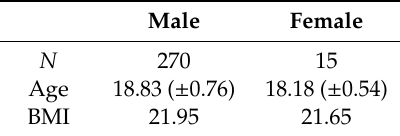
Table 1. Characteristics of